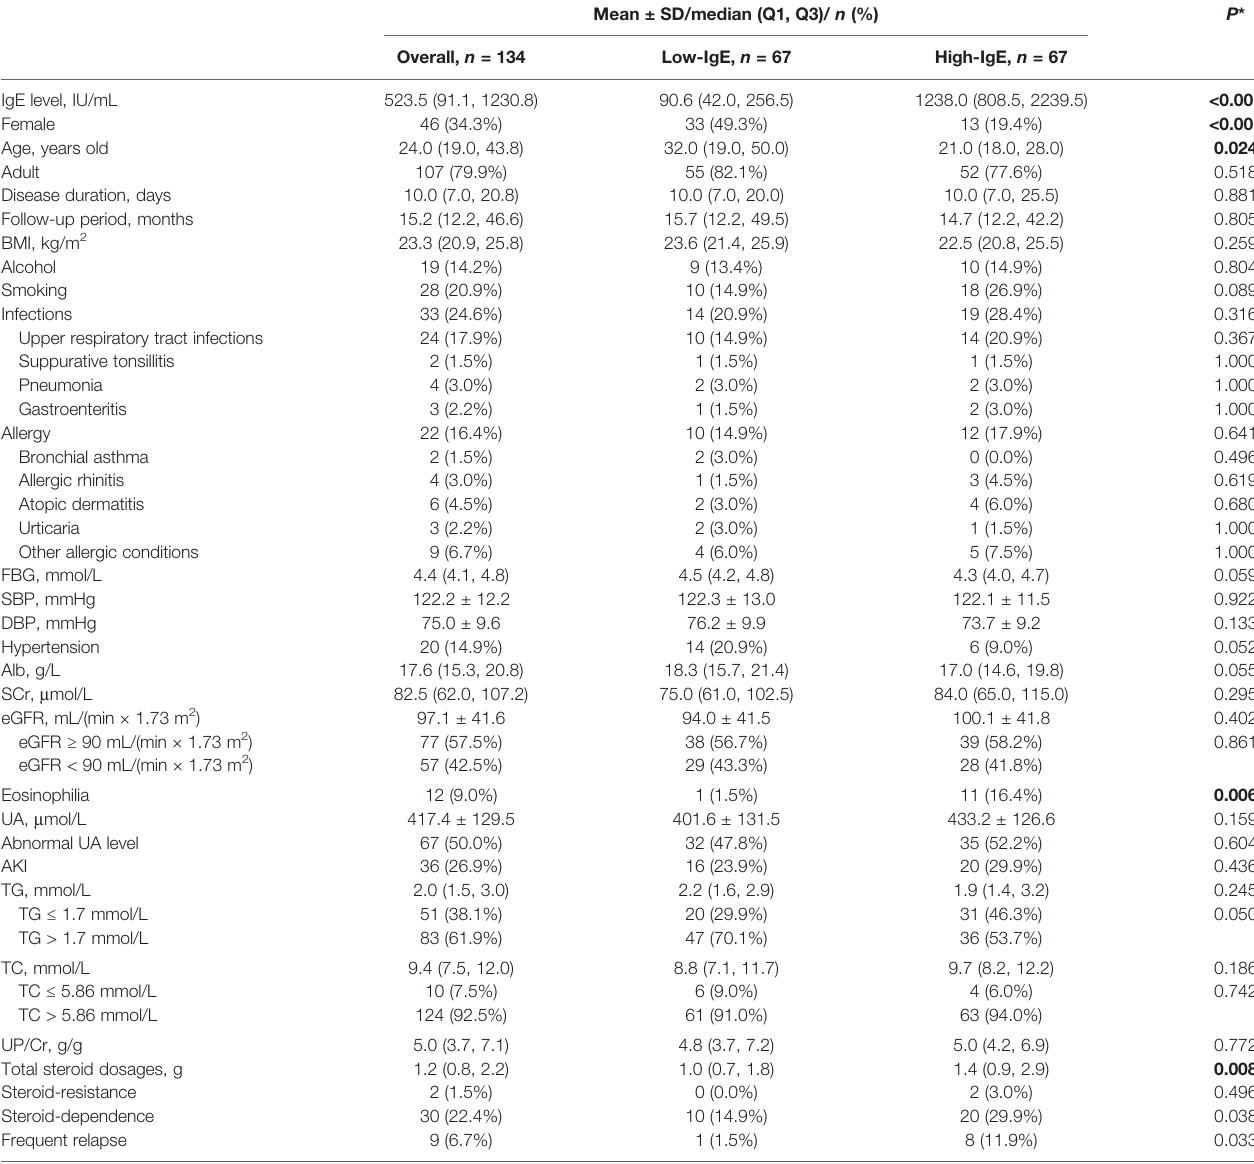
TABLE 2 | Baseline characteristics of patients with minimal change disease treated with